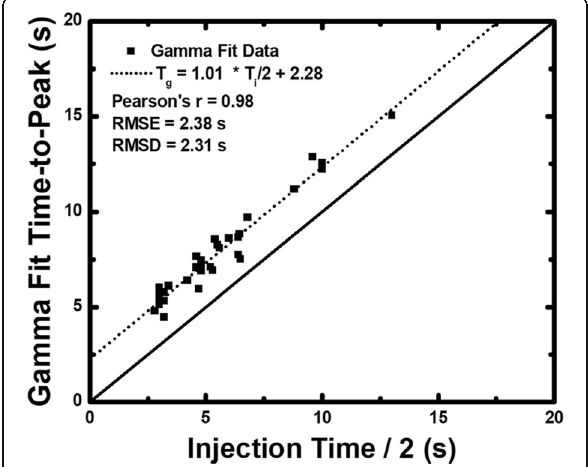
Fig. 3 Gamma fit time-to-peak data as compared to the one half injection time data. A total of 98 measurements from 28 animals were obtained, and the time-to-peak of the aortic enhancement in each case was retrospectively assessed through automatic gamma variate fitting. The average gamma fit time-to-peak data from each animal was then quantitatively compared to the ideal bolus timing theory through regression analysis. T g time-to-peak of the aortic enhancement, defined as the time between the peak of the second derivative of the gamma fit and the true peak of the gamma fit, T i contrast injection time, RMSD root-mean-square deviation,